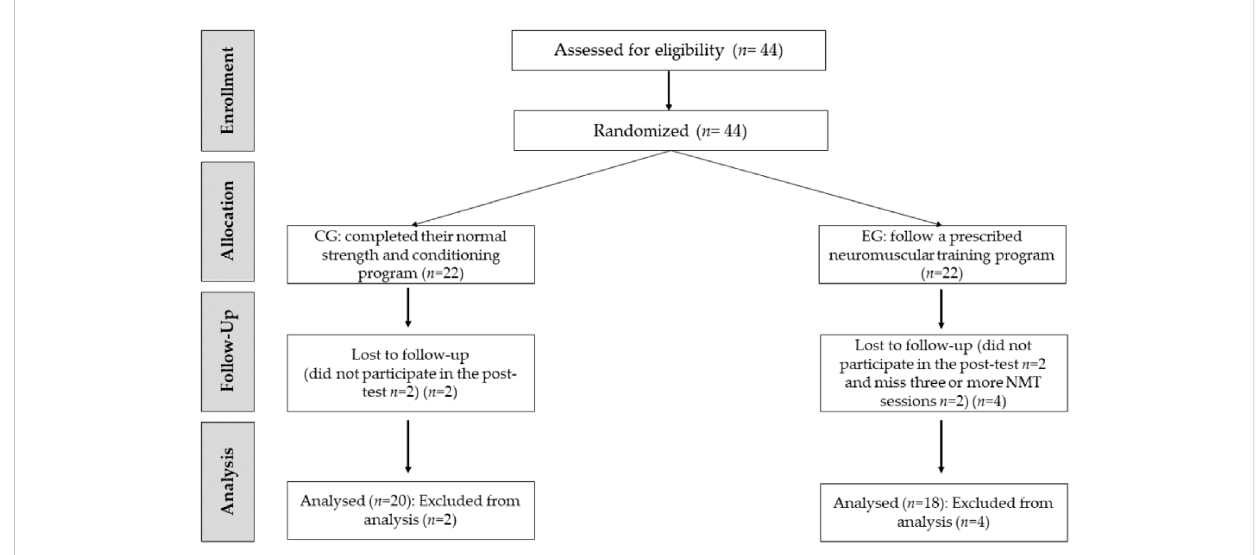
FIGURE 1 Recruitment process described in a CONSORT